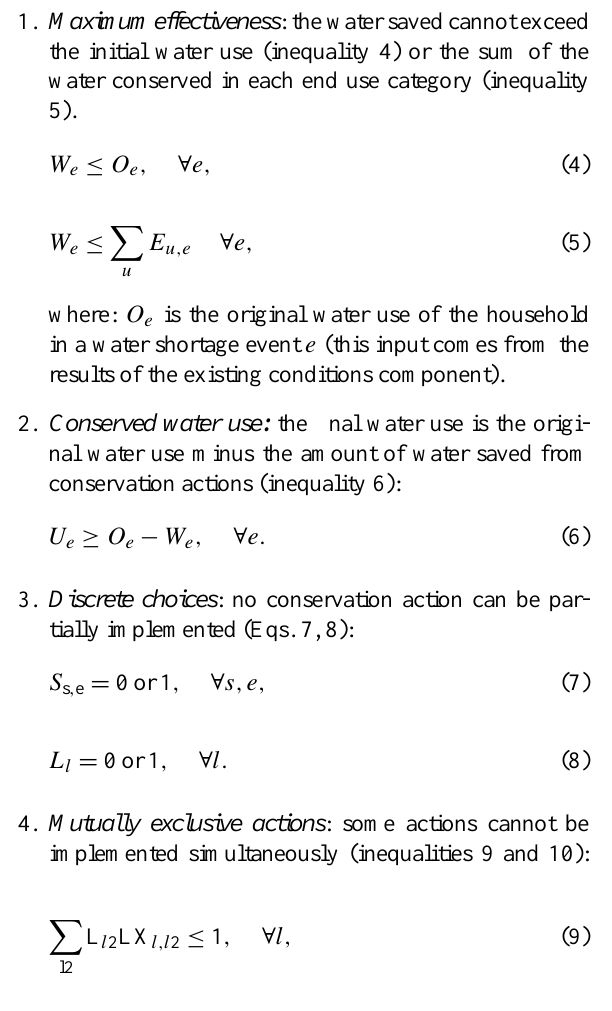
Table 3. Description of water shortage events. Event Description